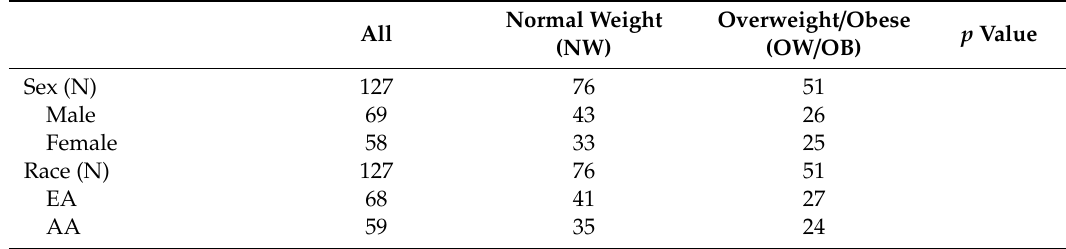
Table 1. General characteristics of the study